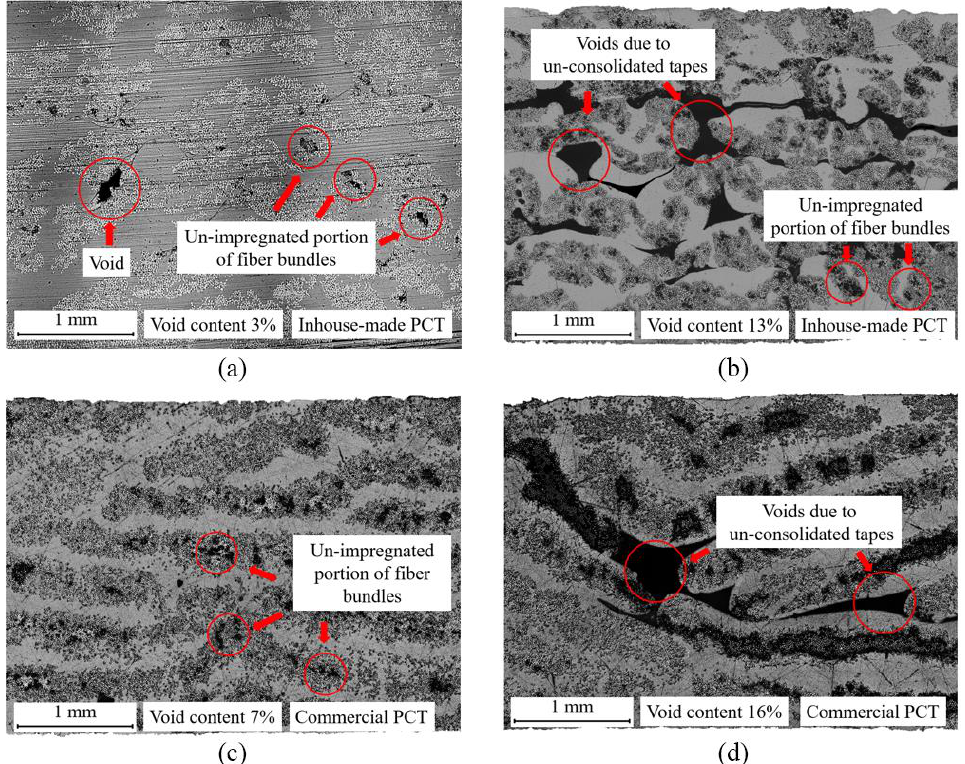
Figure 8. Areas of micrographs of pultruded thermoplastic flat GF/PP laminates: ( a ) flat laminate based on inhouse-made PCTs, area with the lowest void content of 3%; ( b ) flat laminate based on inhouse-made PCT, area with the largest void content of 13%; ( c ) flat laminate based on commercial PCTs, area with the lowest void content of 7%; ( d ) flat laminate based on commercial PCTs, area with the largest void content of 16%.